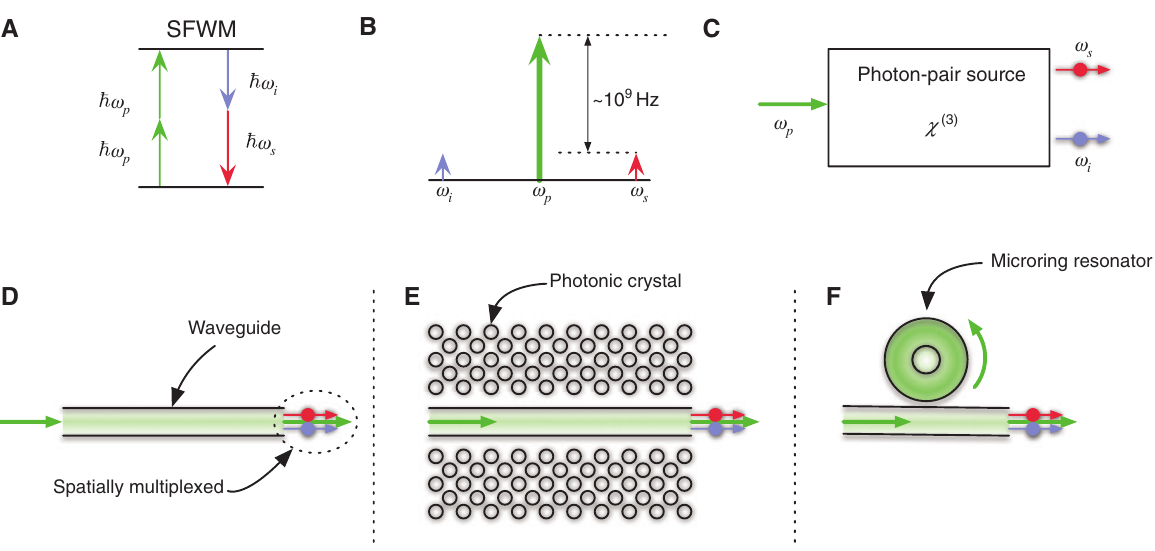
are annihilated, creating a pair of quantum-correlated Figure 5: Integrated SFWM structures. (A) SFWM process. Two photons of energy  ω p photons of energies  ω and  ω , respectively. (B) Schematic comparison of photon-pair intensity to the pump field, which is typically a s i factor of 10 9 higher intensity. (C) Ideal model of a photon-pair source based on SFWM. A pump field is incident on a χ (3) nonlinear crystal; the photon pair at the output is spatially demultiplexed and the pump field is not present. (D–F) Integrated SFWM structures used to enhance the pump intensity, resulting in a higher photon-pair output flux for a given input pump flux with respect to bulk-optical implementations. (E) A slow-light photonic crystal structure with a high group index increases the nonlinear interaction time, giving rise to a higher output flux intensity. (f) A microring resonator structure integrates the pump field, resulting in a higher output flux